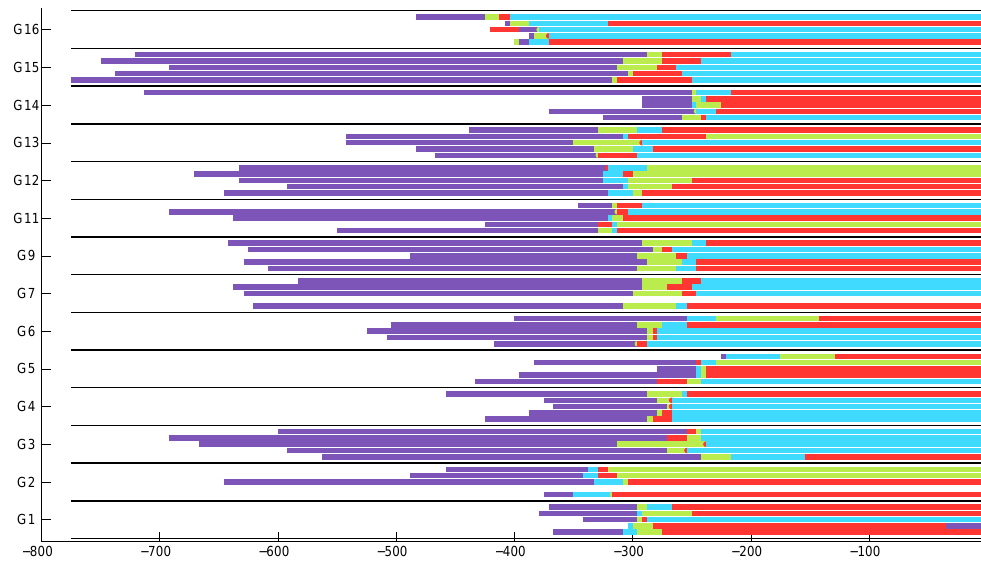
Figure A2. Illustration of transition sequences for 14 golf players ( ∼ 5 shots each), where color change means the change of rotation direction. The sequence of colors (violet, green, red and blue) for player G15 corresponds to the correct transition sequence (pelvis, thorax, arm and club). Note: position in samples on the X (horizontal) axis is shown, where 0 corresponds to the moment of impact.